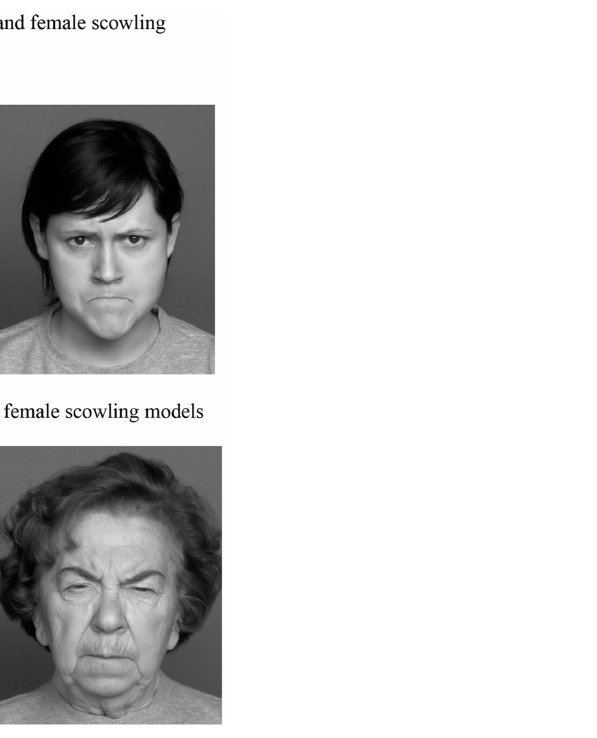
FIGURE 1 | Facial photographs (Ebner et al., 2010) the Center for Lifespan Psychology, Max Planck Institute for Human Development, Berlin, Germany. Used with permission from the Max Planck Institute. These models are examples of images used in this study and not the actual images used. (A) Examples of young male and female scowling models. (B) Examples of old male and female scowling